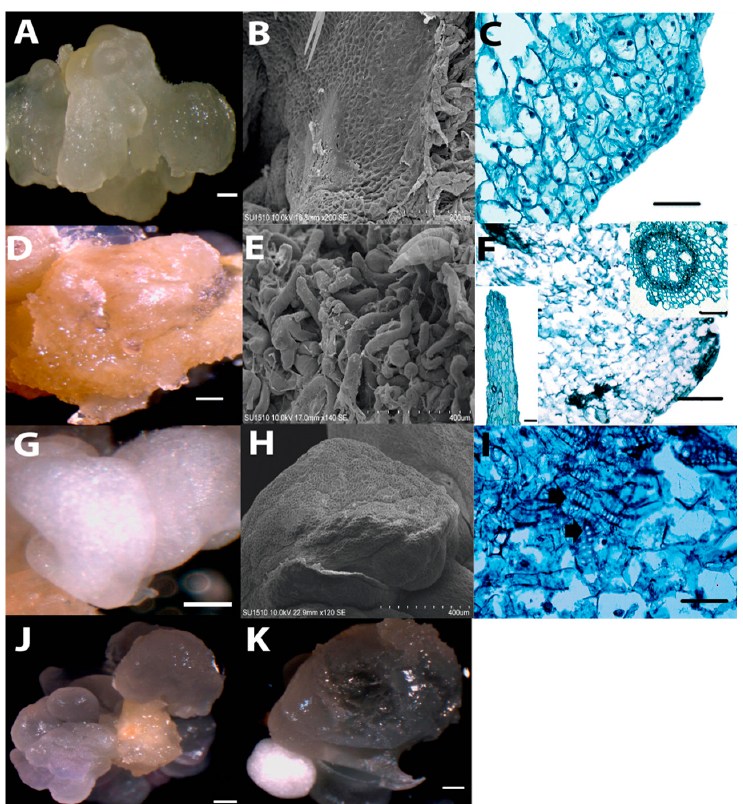
Figure 2. Different callus types observed during subcultures of Tuxpeño VS-535. ( A ) A portion of translucent embryogenic callus (EC). ( B ) EC observed with SEM. ( C ) Histological analysis of EC. Characteristic small isodiametric cells with prominent nuclei are observed at the callus surface. ( D ) A portion of yellow non-embryogenic callus (Y-NEC). ( E ) Y-NEC observed with SEM. ( F ) Histological analysis of Y-NEC. Larger cells with smaller nuclei can be appreciated. The inset images represent a root-like structure (right) and a vascular bundle (left) frequently observed for this callus type. ( G ) A portion of white non-embryogenic callus (W-NEC). ( H ) W-NEC observed with SEM. ( I ) Histological analysis of W-NEC. The arrows indicate tracheid structures present in this callus type. ( J ) and ( K ) Portions of callus tissues showing the co-existence of EC with Y-NEC and W-NEC, respectively. Histological analyses are shown at ×400 magnification. Bar in A , D , G and H : 1 mm. Bar in C , F and I : 100 μ m.